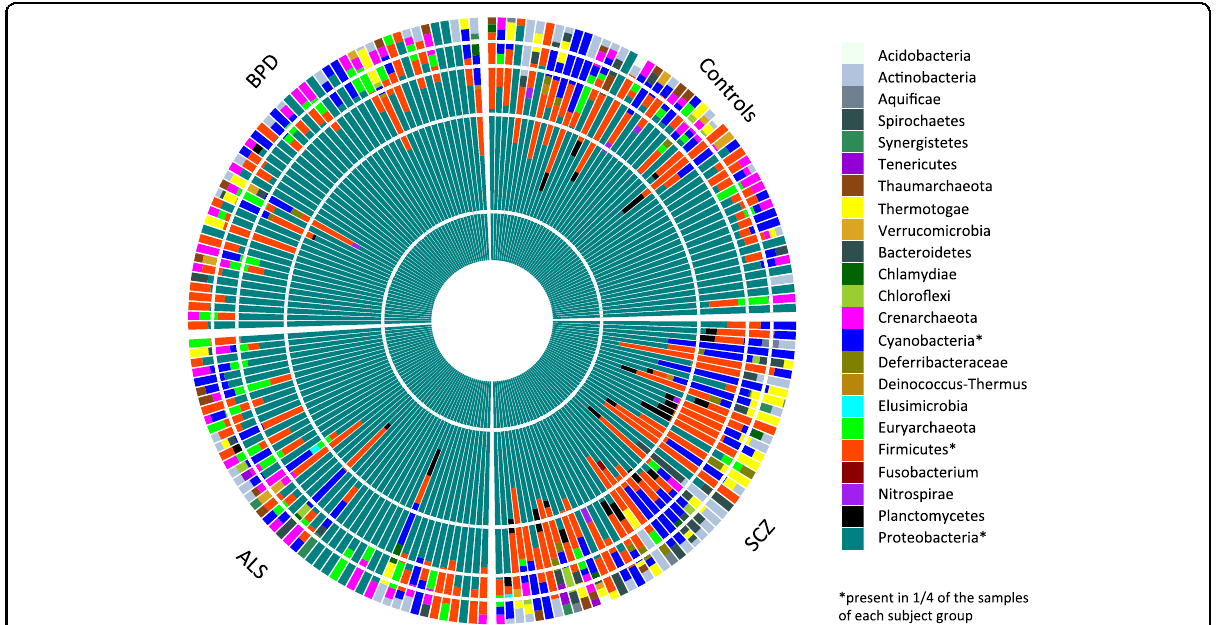
Fig. 2 Relative abundances of microbial taxa at phylum level. Phylogenetic classi fi cation is performed using PhyloSift, which is able to assign the fi ltered candidate microbial reads to the microbial genes from 23 distinct taxa on the phylum level